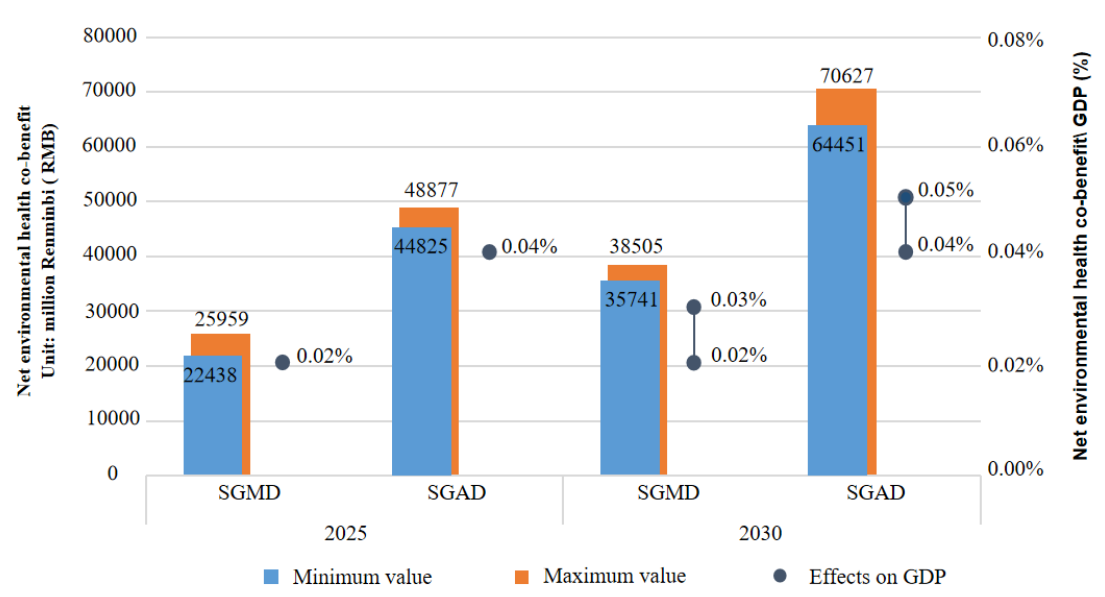
Figure 13. Net environmental health cobenefit of pollutants.